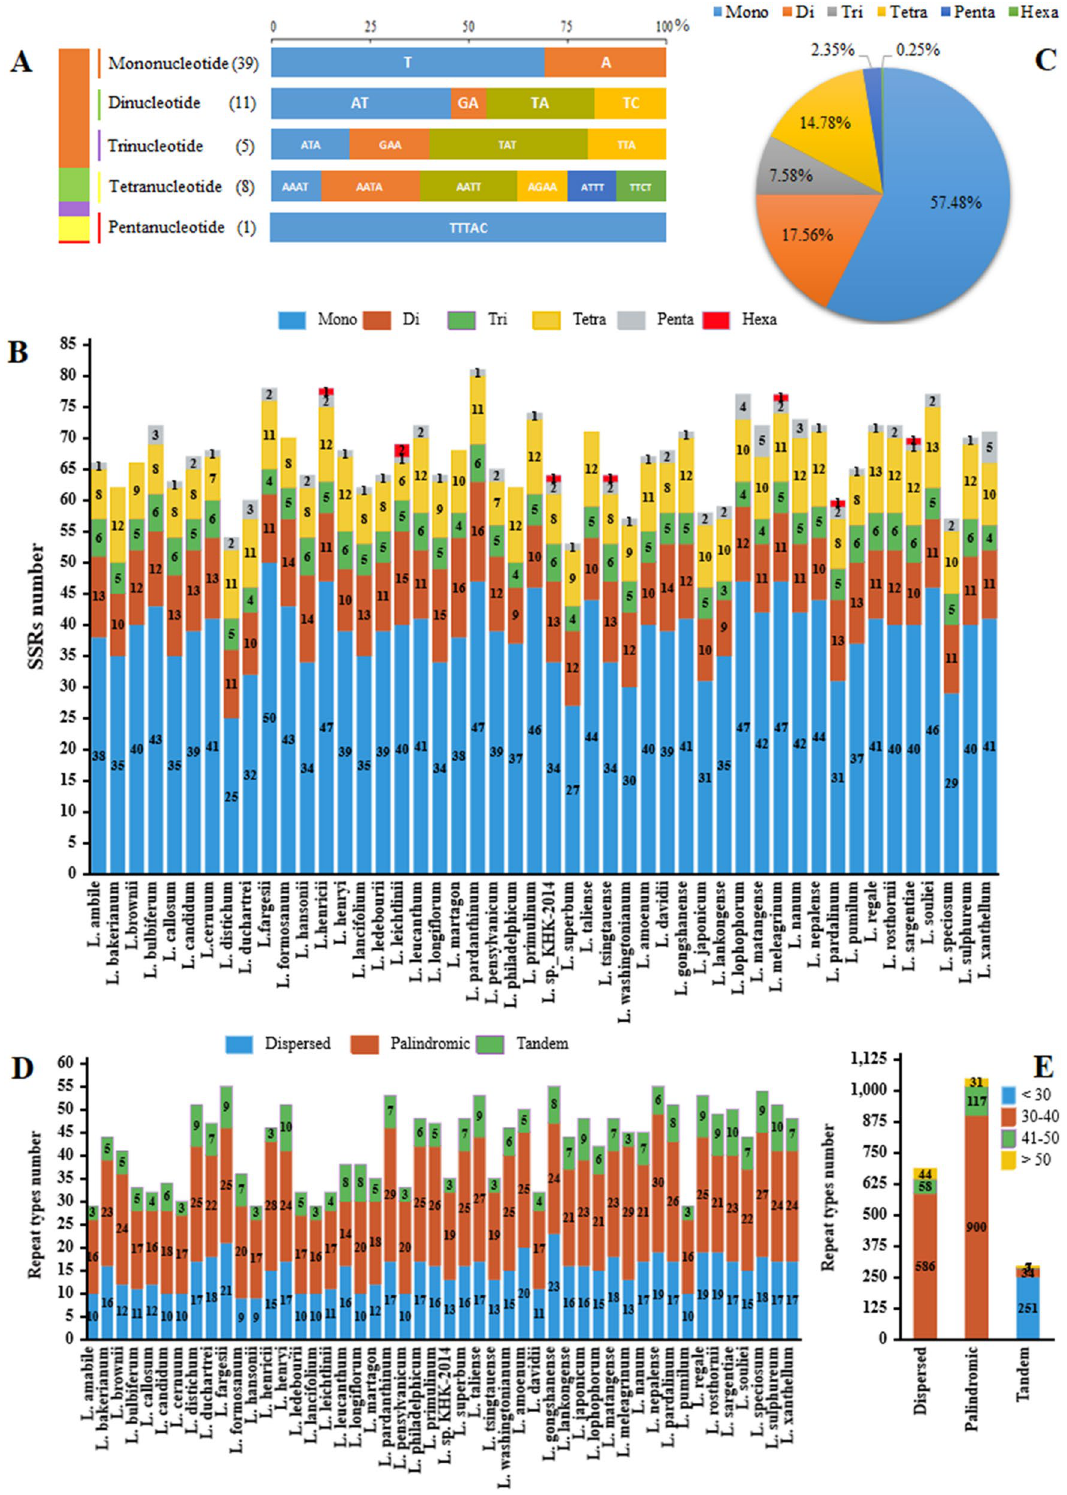
Figure 4. The type and distribution of simple sequence repeats (SSRs) and complex repeat in the 48 Lilium cp genomes. ( A ) Frequency and type of SSRs in the L. ledebourii cp genome. ( B ) The number of SSR types discovered in 48 Lilium cp genomes. ( C ) The percentage of SSrs types in 48 Lilium cp genomes. ( D ) The number and of complex repeats types in 48 Lilim cp genomes. ( E ) Frequency of complex repeats by